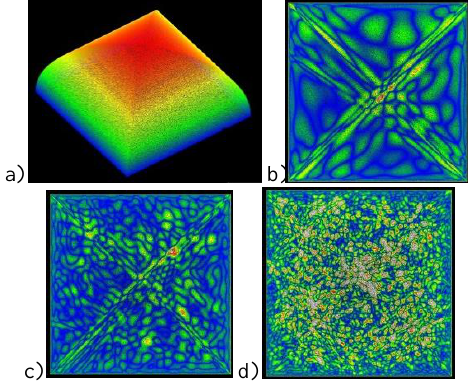
Figure 9. Results for a synthetic cloister vault with a unique layer: (a) original point cloud; (b) result with 50 neurons; (c) results with 200 neurons; and (c) results with 1000 neurons (color scale is the same for images b-c-d).